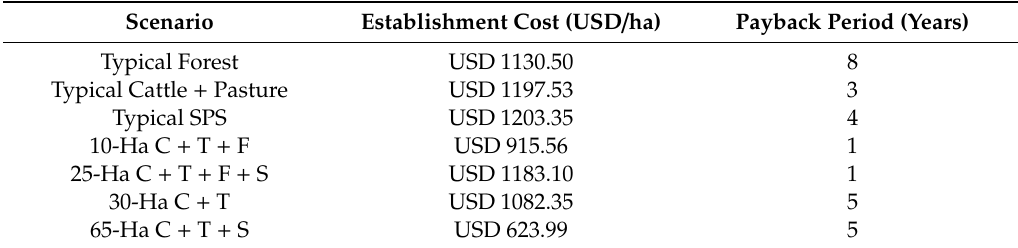
Table 4. Establishment costs (not discounted) and payback periods for all